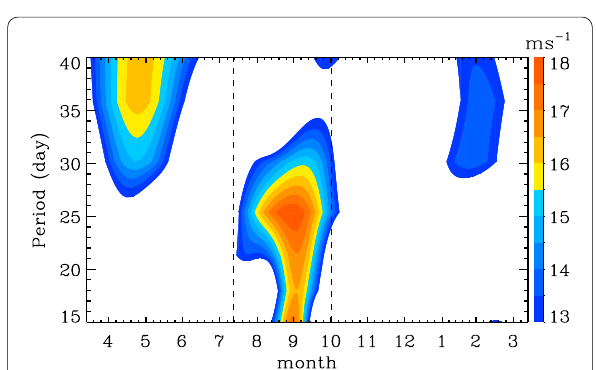
Fig. 3 Wavelet spectrum of zonal wind at 100 km for 1 year from 13 April 2006 to 12 April 2007. The months are marked on the last day of each month. The two dashed vertical lines are marked on 12 August 2006 and 31 October 2006, respectively